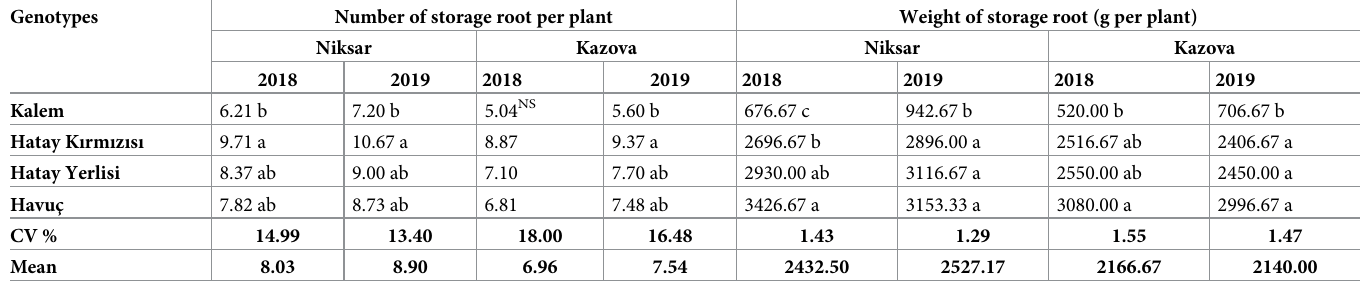
Table 3. The number and weight of storage roots per plant (g) for different local sweet potato genotypes used in the study.